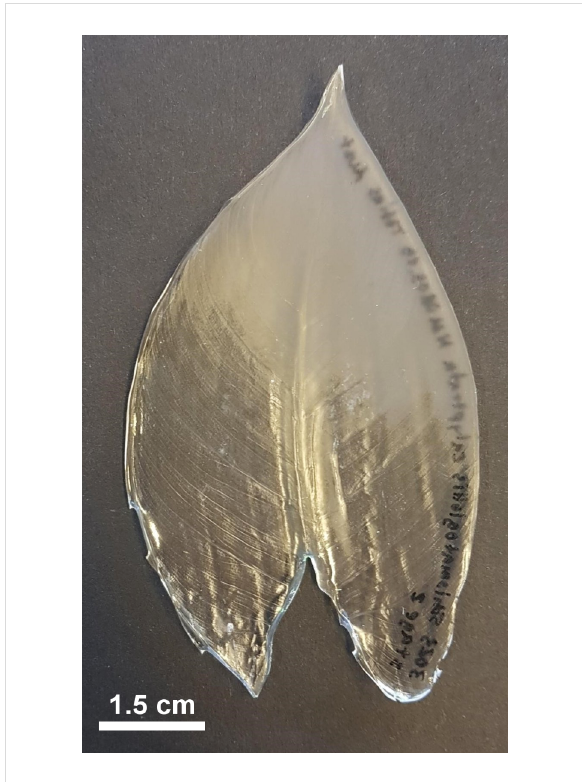
Figure 4: A typical epoxy replica of the surface of a leaf at growth stage 2 having a ridge progression inclined with the midrib. The trans- parent region represents stage 2B and contains smooth cells. The opaque region represents stage 2A and contains densely arranged high aspect ratio cuticular ridges. The inclined ridge progression might be the result of uneven exposure of the leaves to the outside environ-